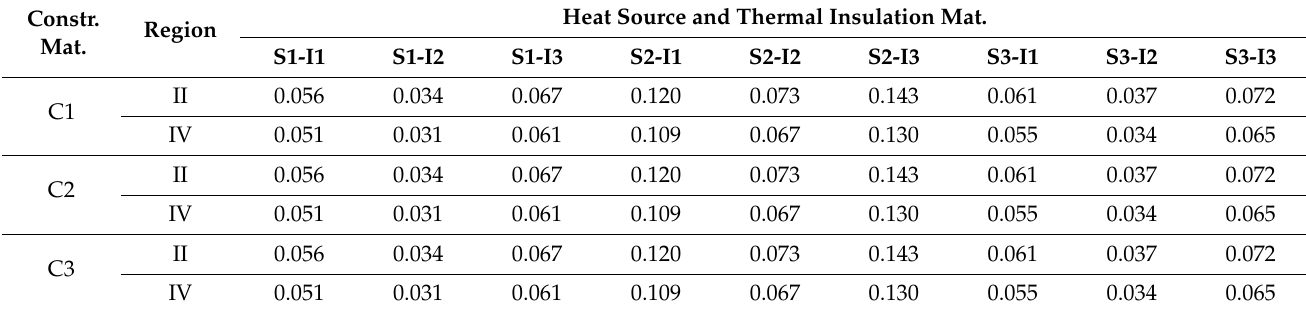
Heat Source and Thermal Insulation